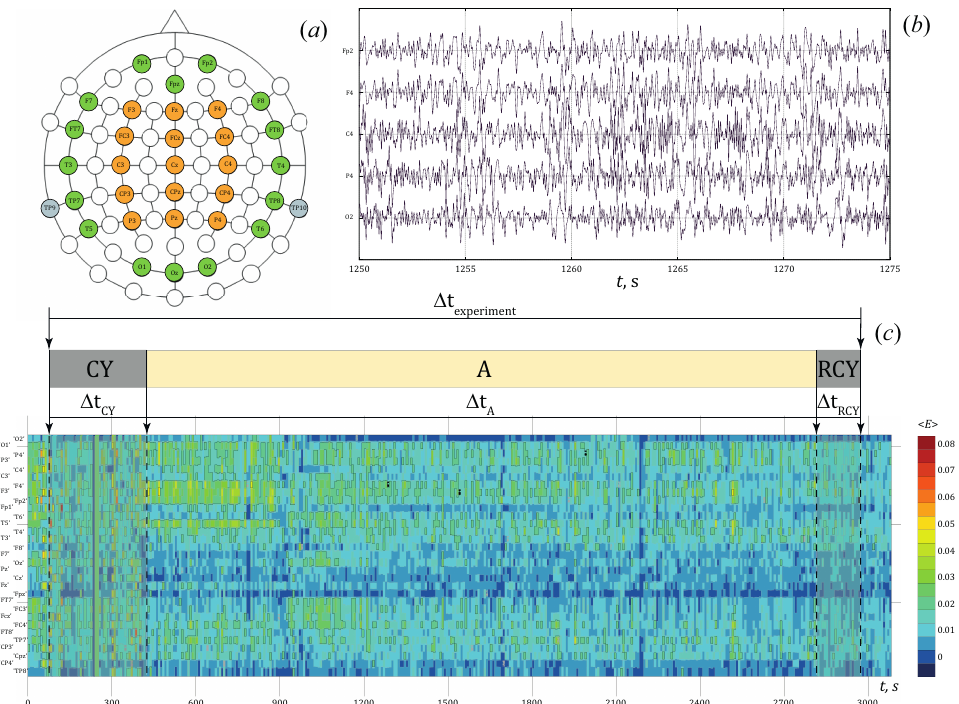
Figure 1. ( a ) The scheme of the “10–10” EEG electrode arrangement; ( b ) Fragments of EEG signals recorded during the experimental active stage; ( c ) The time dependence of the wavelet-energy in the band [ 8;12 ] Hz by